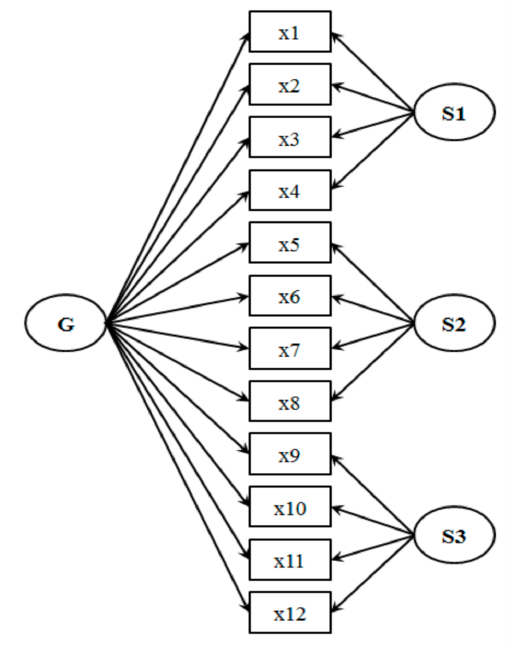
Figure 1. A bifactor model with three specific